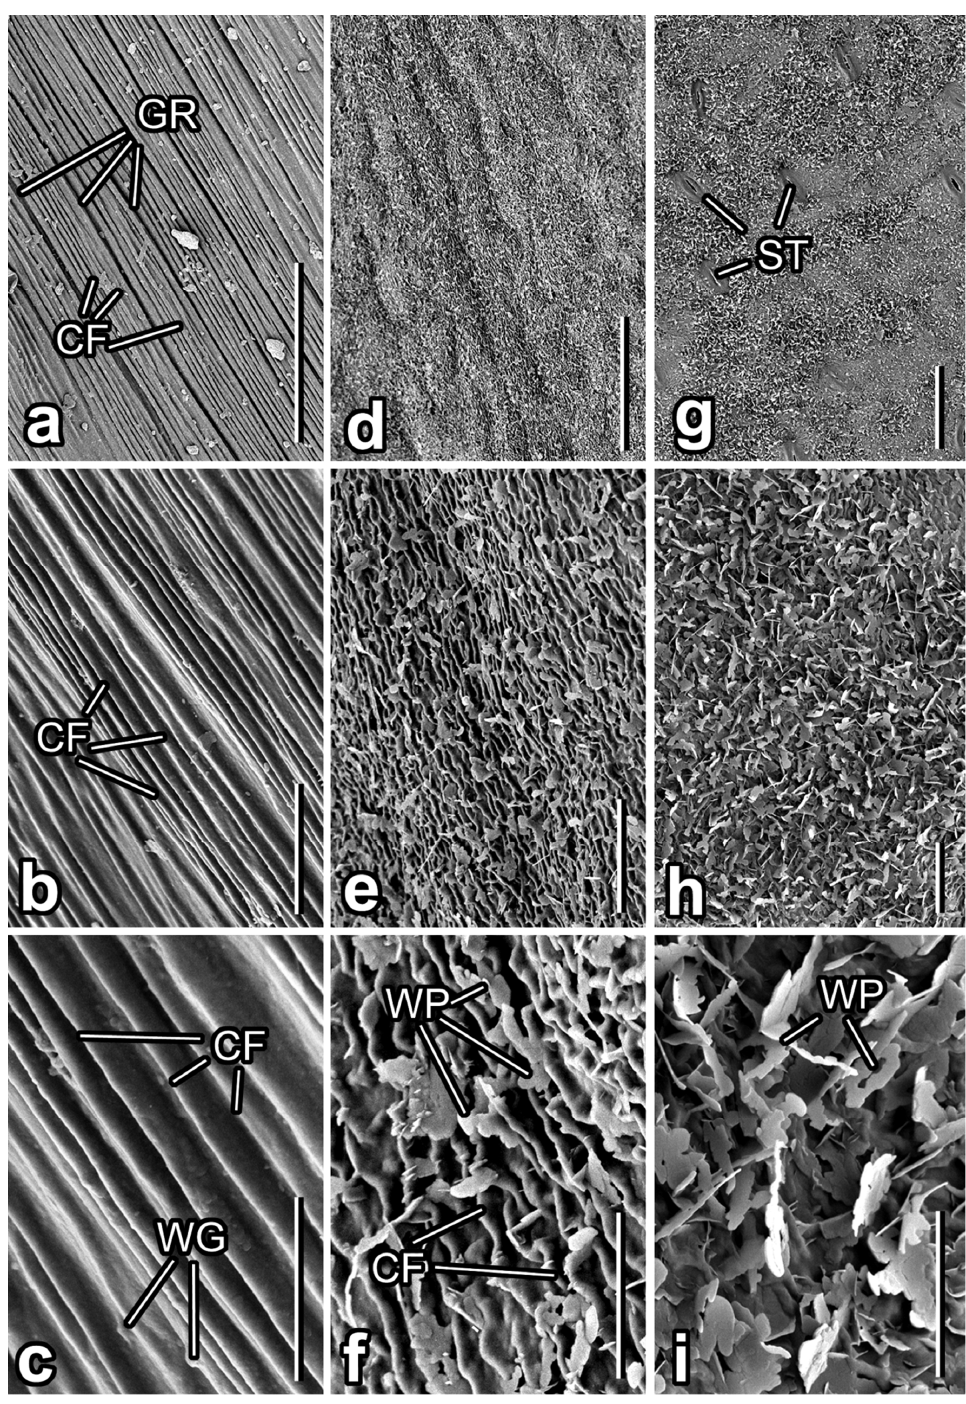
Figure 3. Surfaces of different organs in the Smyrnium rotundifolium plant (cryo-SEM). ( a – c ) Flower stem. ( d – f ) Upper (adaxial) leaf side. ( g – i ) Lower (abaxial) leaf side. Abbreviations: CF—cuticular folds; GR—grooves; ST—stomata; WG—wax granules; WP—wax platelets. Scale bars: 50 μ m ( a , d , g ), 10 μ m ( b , e , h ), 5 μ m ( c , f , i ). The adaxial leaf side is slightly uneven because of the convex shape of the epidermal cells (Figure 3d), and has a prominent hierarchical microstructure composed of a dense